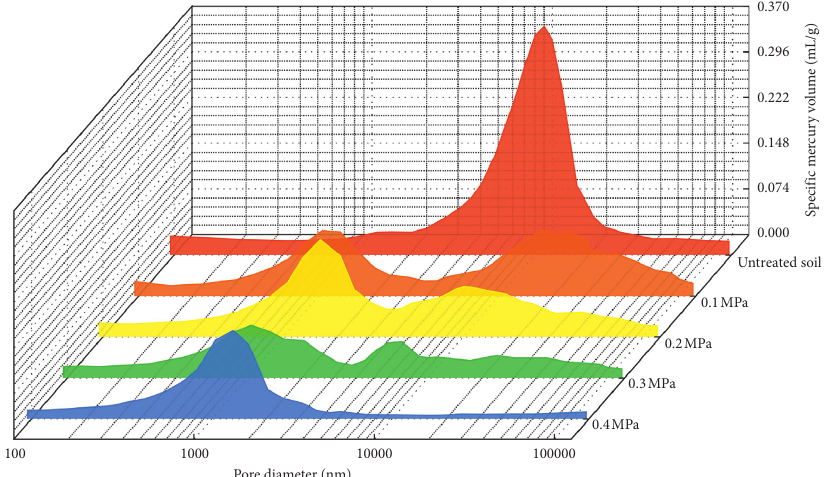
Figure 13: Influence of grouting on aperture distribution.